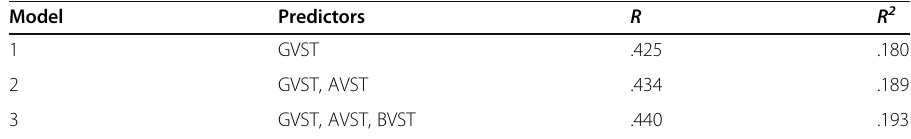
Table 5 Regression analysis of vocabulary predictors and BusGPA